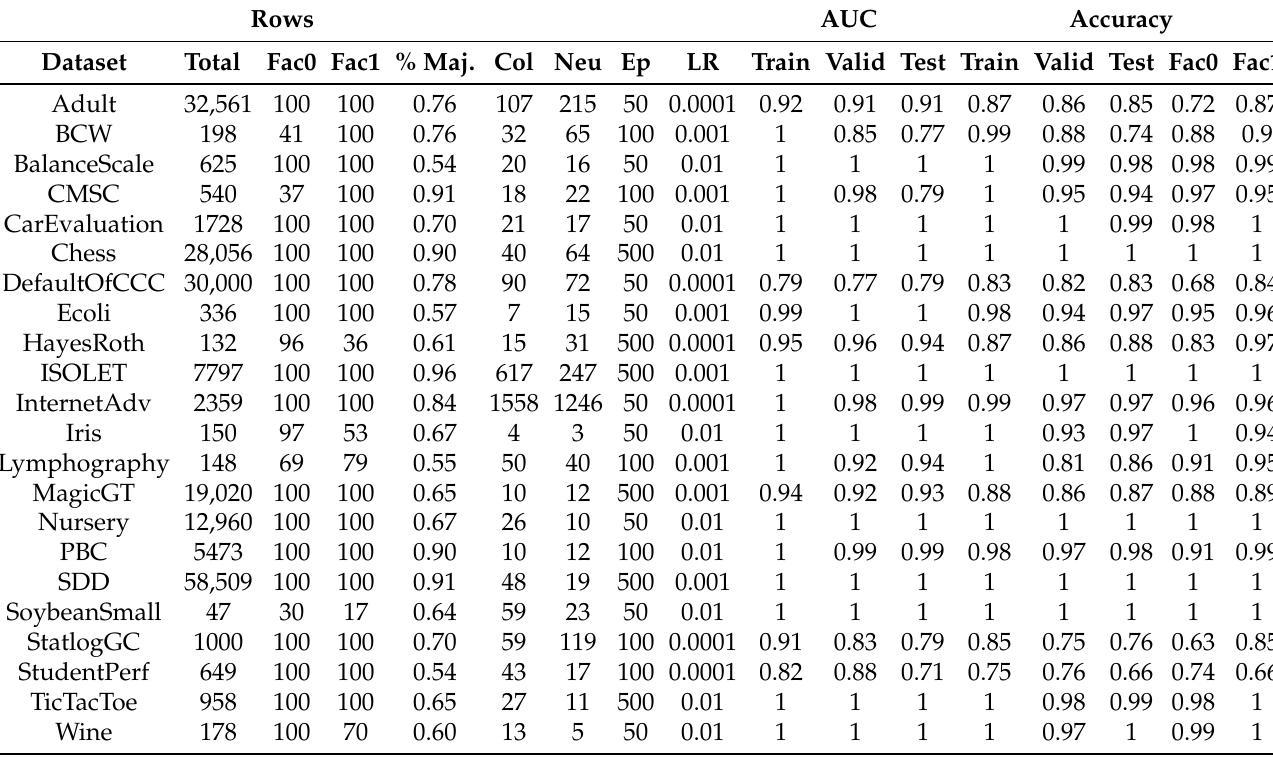
Table A1. Overall data for each dataset and model. fac0 and fac1 are the factual datasets with original class 0 and 1, respectively. The % Maj. is the share of rows of the majority class. Col is the number of columns, Neu is the selected model number of neurons in the single hidden layer, Epc is the number of epochs used in training, and LR is the learning rate.